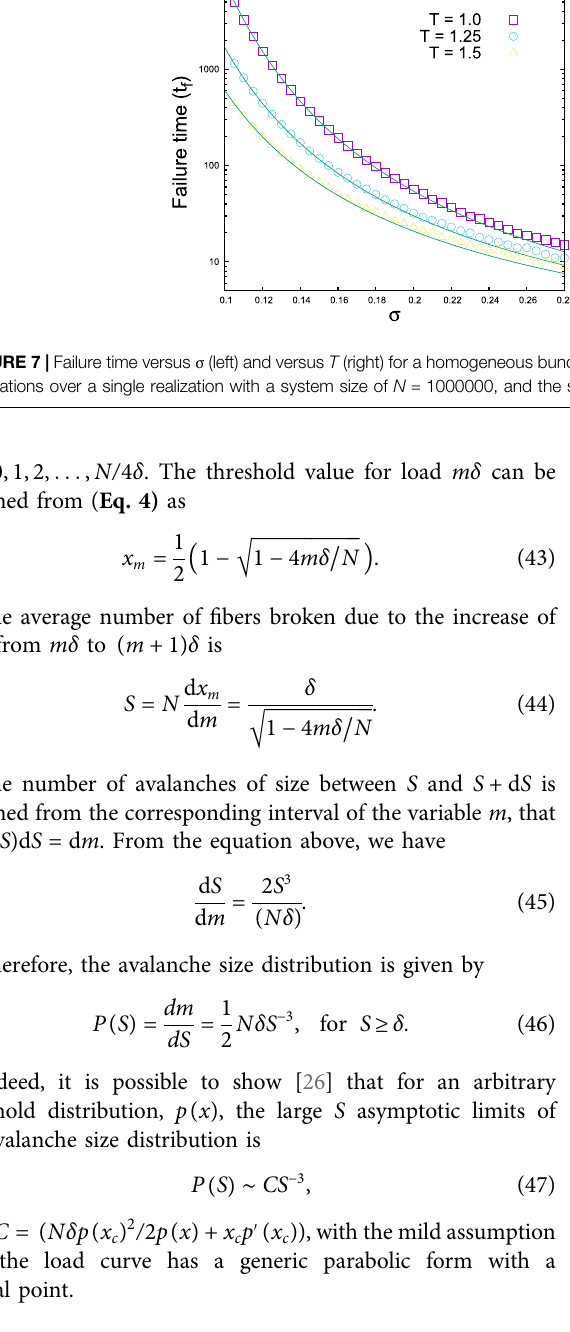
Frontiers in Physics |